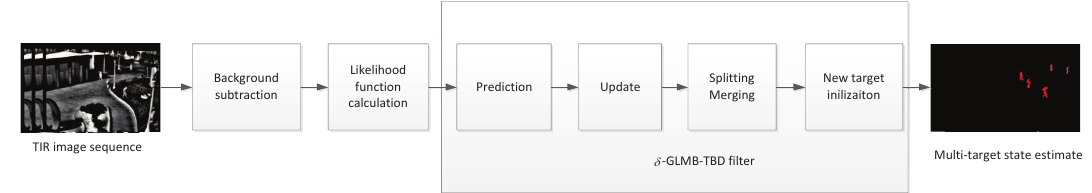
Figure 1. Schematic of the proposed